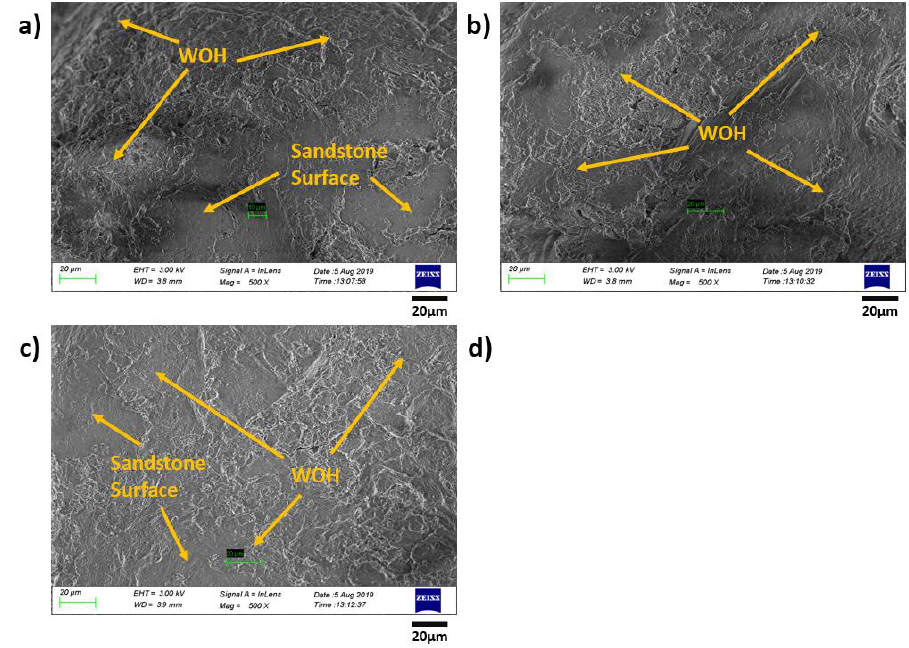
Figure 15. Demonstration of the aggregate in the composites prepared with remolded Pisha aggregate (R-P-1 Type) and 20% EVA modified polyurethane with 8% concentration. ( a – c ) Demonstration of the local structure for the composites prepared with remolded Pisha aggregate (R-P-1 Type) and 20% EVA modified polyurethane with 8% concentration.